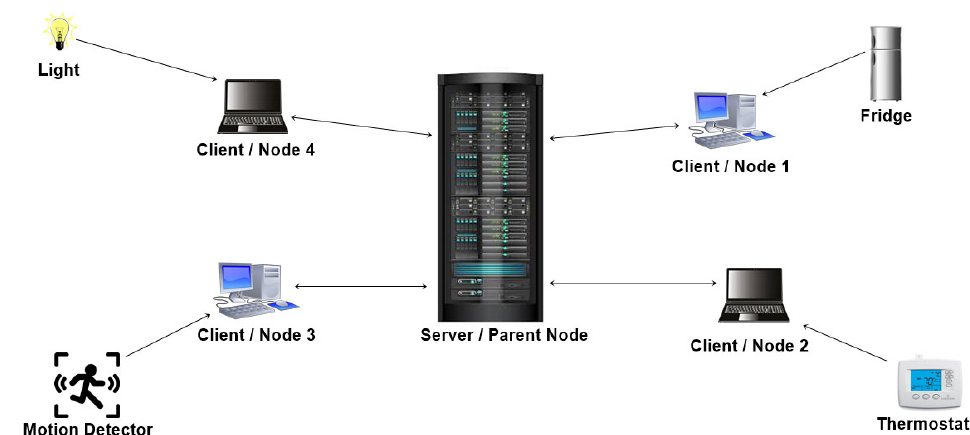
Figure 3. Proposed IoT